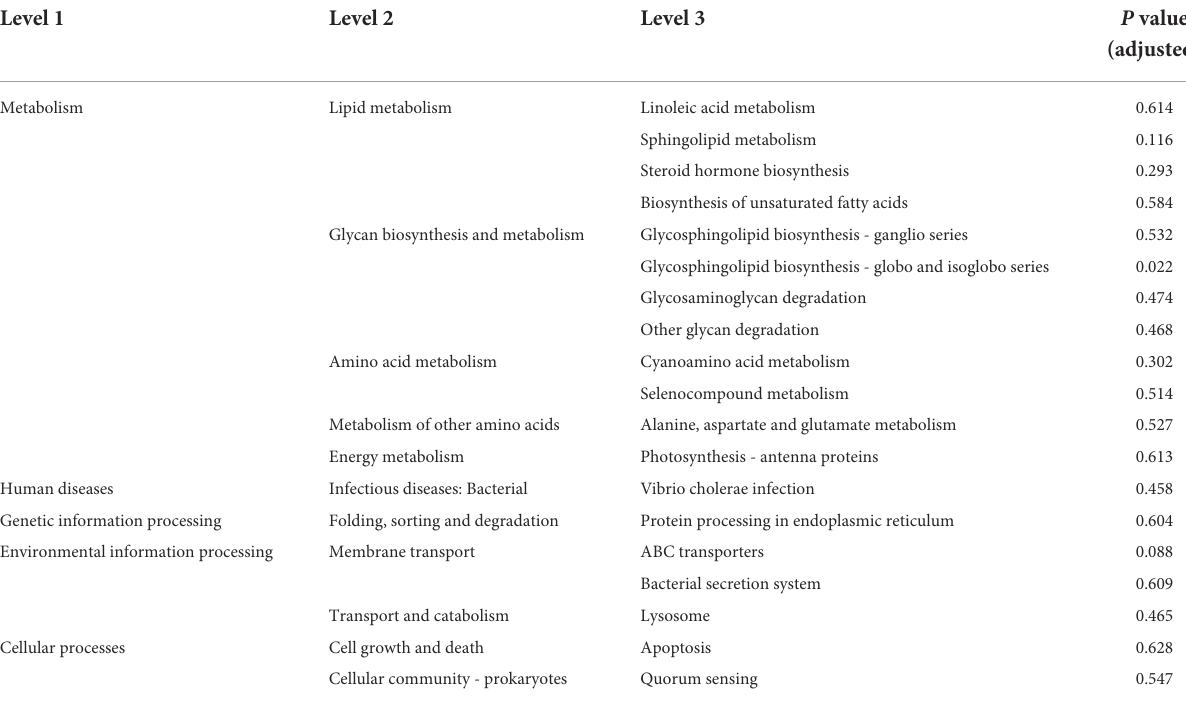
TABLE 2 Functional prediction table of Kyoto Encyclopedia of Genes and Genomes (KEGG) level 3 of mucosa-associated microbiota (MAM). Level